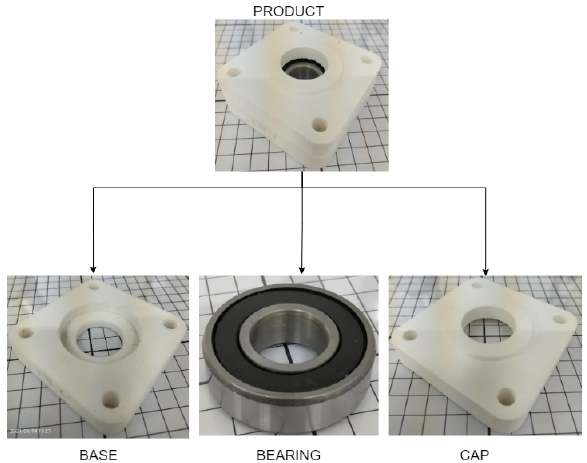
Figure 2. Collaborative assembly elements in the secondary